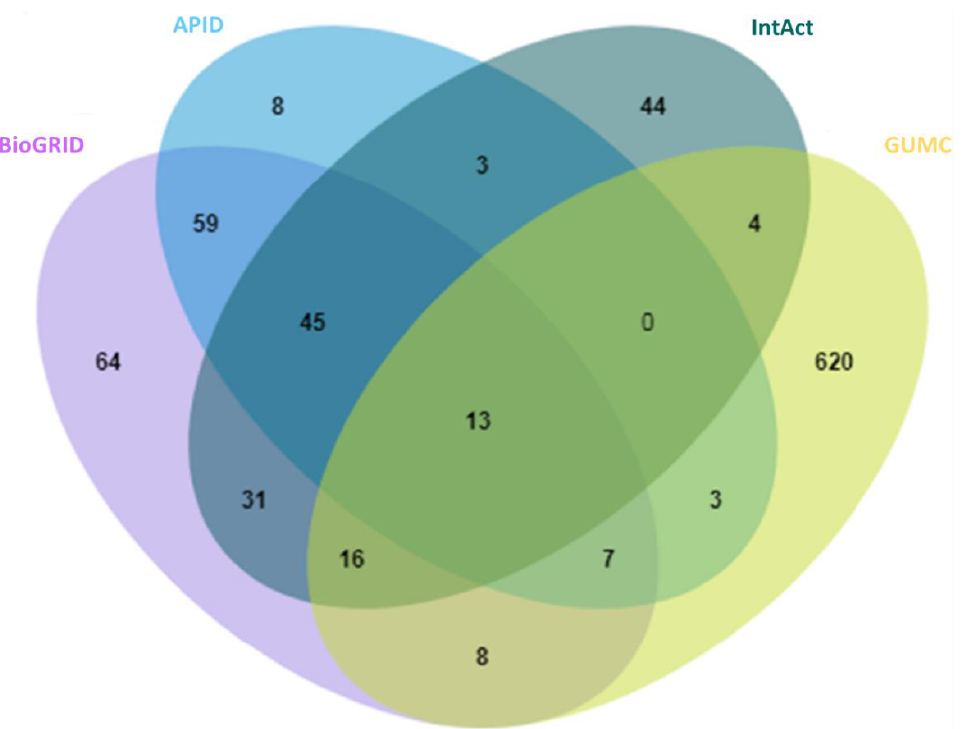
Figure 2. Overlap of 929 high-stringency OGT-interacting proteins from different sources, including BioGRID, APID, IntAct, and GUMC (denoting OGT-interacting proteins additionally extracted and curated by the team at the Georgetown University Medical Center). Curated OGT-interacting proteins obtained from HIPPIE, HuRI, and PlaPPISite were not included for this comparison, due to the presence of only a few additional proteins.